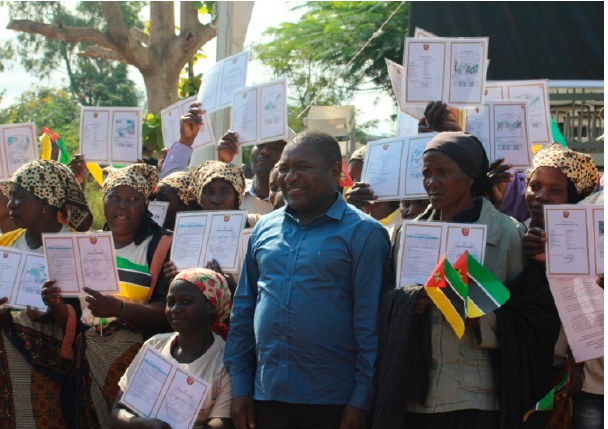
Figure 12. A group of women getting their land titles from the president of Mozambique.